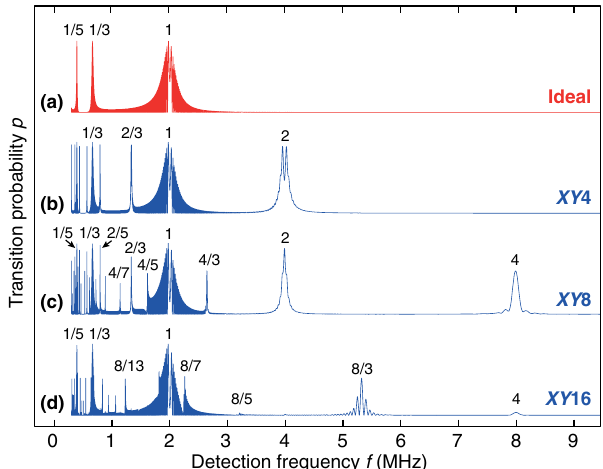
FIG. 2. Simulated spectra showing response as a function of detection frequency f ¼ 1 = ð 2 τ Þ for coupling to a single ω = ð 2 π Þ ¼ 2 MHz and Ω ¼ a = 2 ¼ nuclear spin with f 0 ⊥ ac ¼ 2 π × 200 kHz. (a) Ideal sensing sequence with infinitely short π =k are observed. (b-d) Real pulses. Only the expected peaks at f ac XY 4 , XY 8 , and XY 16 sequences [26] with finite, square-shaped π =k , 4 f =k , and 8 f =k are pulses. Additional peaks at 2 f ac ac ac observed, leading to a dense “ forest ” of peaks. The number of pulses is N ¼ 480 , the Rabi frequency is ω 1 = 2 π ¼ 20 MHz, and detuning (for c,d) is Δ z ¼ 1